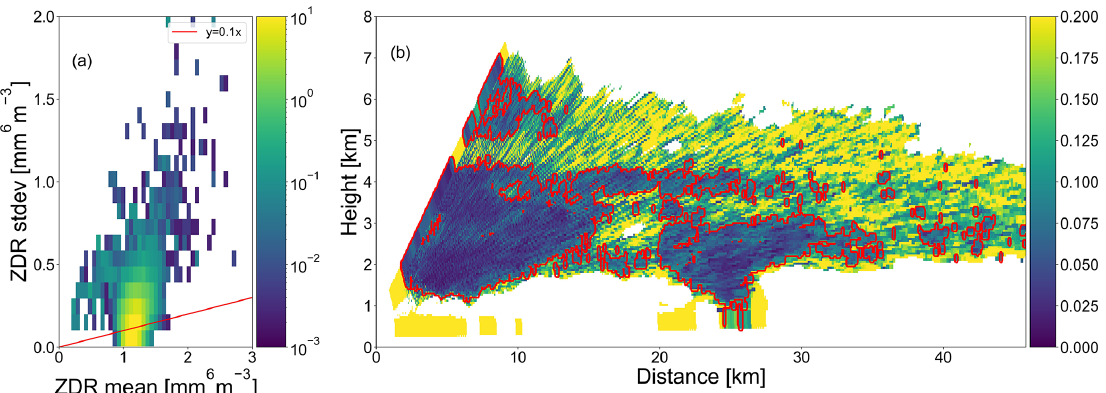
Figure A2. (a) The local standard deviation of ZDR is plotted as a function of the local mean of ZDR using a 2D density histogram of the calculated parameters (the color bar indicates the density values). (b) The ratio a = ZDR SD / ZDR mean can be used to filter out noisy ZDR measurements (values of ZDR are indicated with the corresponding color bar). In the red encircled areas ( a < 0 . 1), the retrieval results are considered to be reliable enough to be aggregated into statistical results.